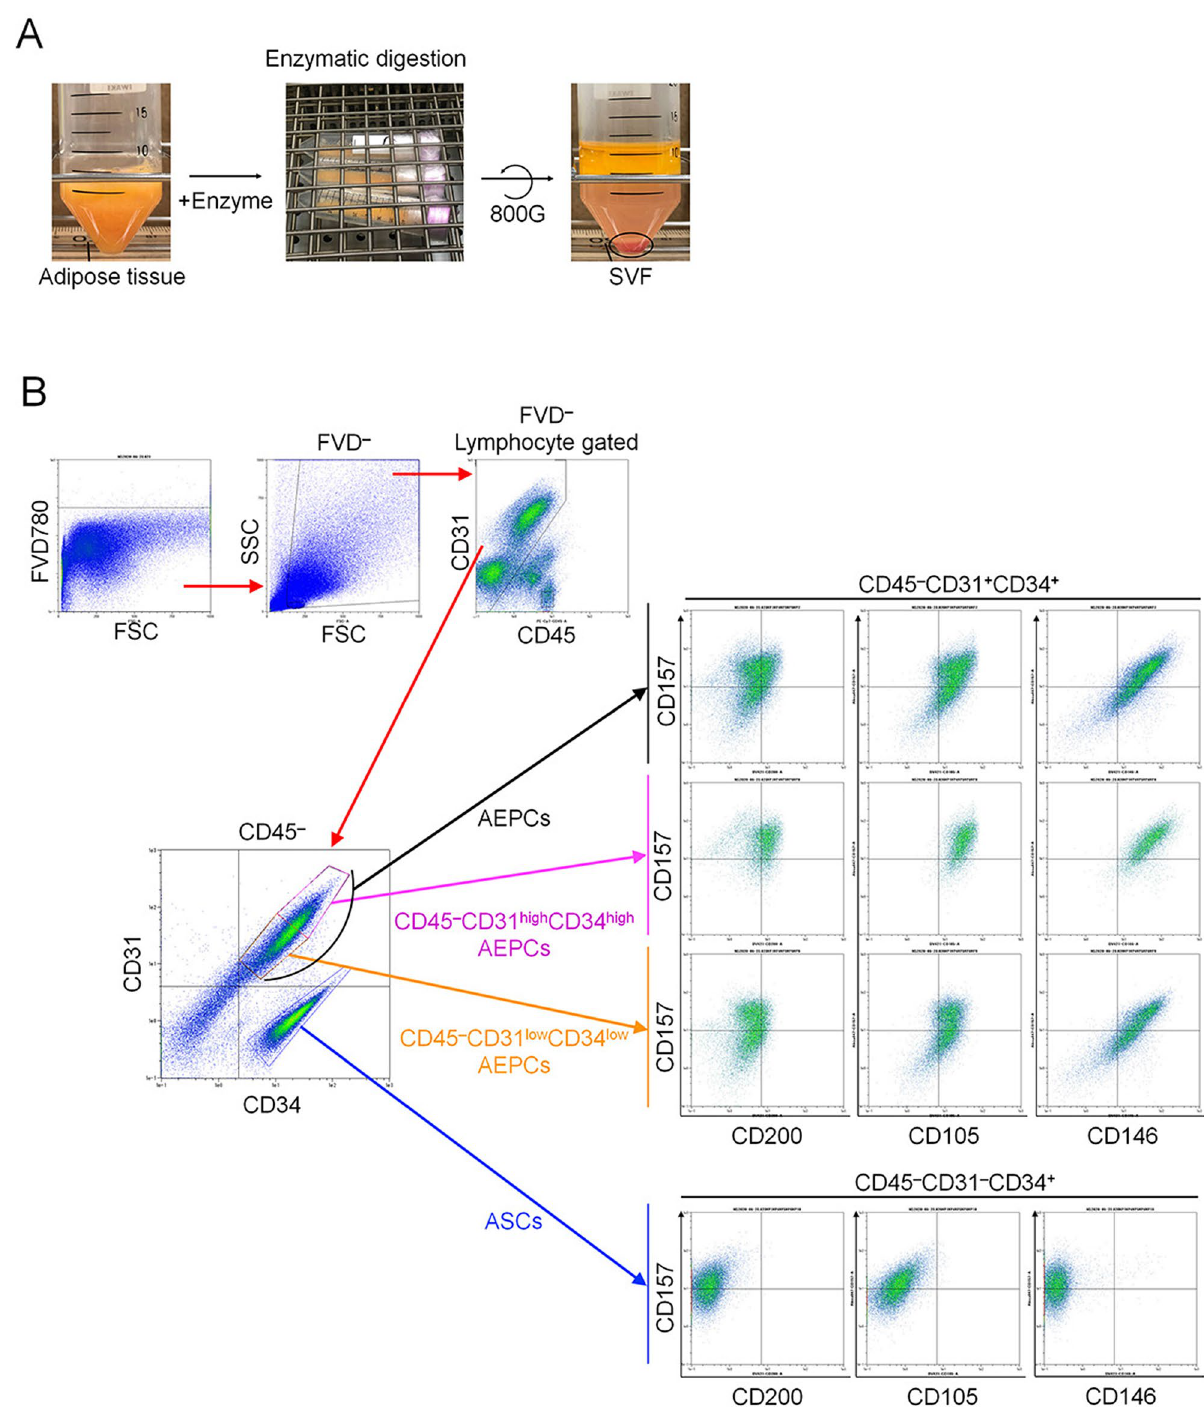
Figure 1. SVF extraction and characterization. ( A ) The SVF was enzymatically isolated from human lipoaspirates using a collagenase-based enzymatic solution at 37 °C for 30 min at 120 rpm of reciprocating motion, followed by centrifugation at 800× g for 10 min. The open circle indicates the SVF pellet. ( B ) The freshly isolated SVF was characterized by the expression of CD45, CD34, CD31, CD105, CD146, CD157, and CD200 during the flow cytometry analysis. The experiment was performed independently 3 times (3